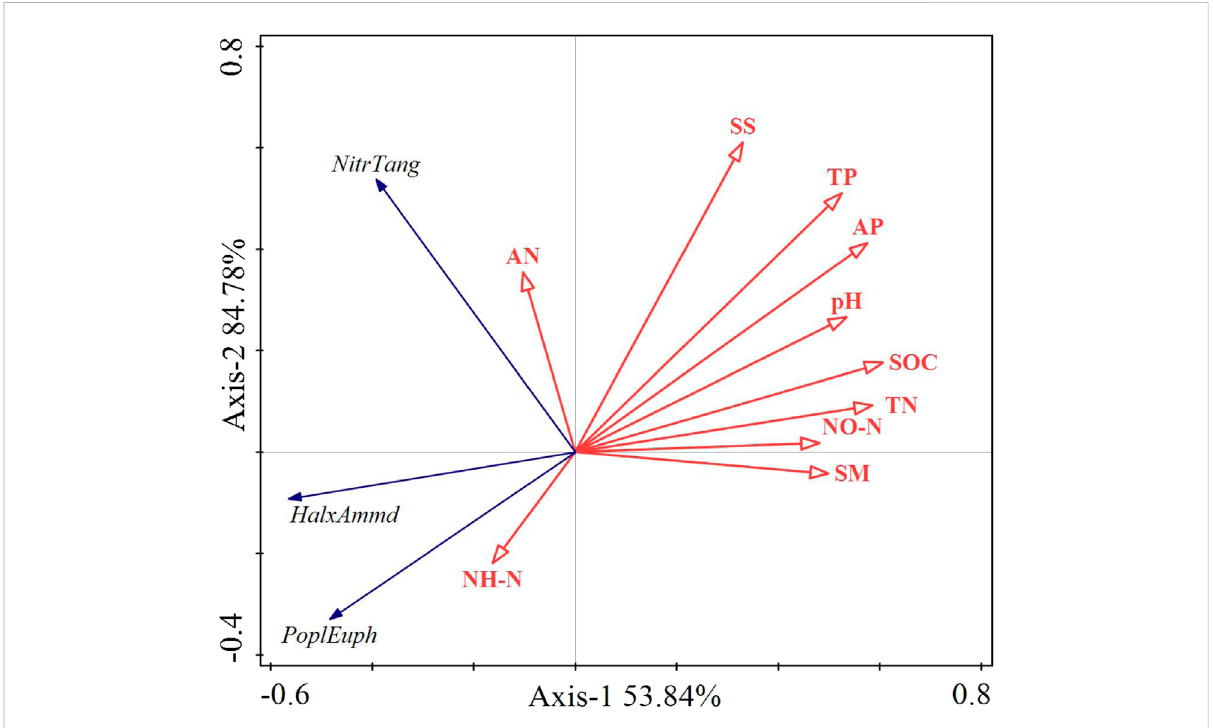
FIGURE 4 Redundancy analysis based on the correlation between soil physico-chemical properties and the overall plant fertilizer island effect. Note: PoplEuph, Populus euphratica ; HalAmmd, Haloxylon ammodendron ; NitrTang, Nitraria tangutorum ; NO-N, nitrate nitrogen; NH-N, ammonium